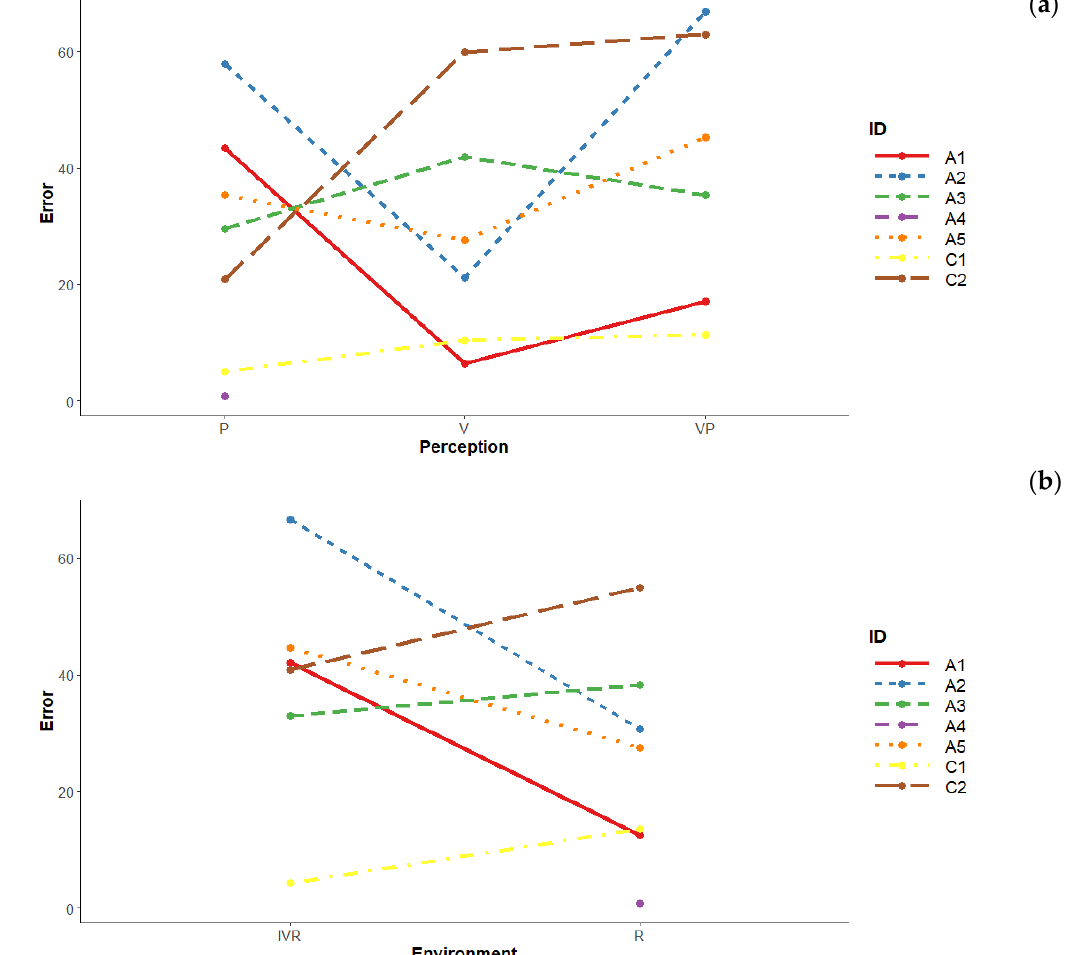
Figure 4. ( a ) Mean error made by each participant according to perception (marginalised over the other variables). ( b ) Mean error made by each participant according to environment (marginalised over the other variables).